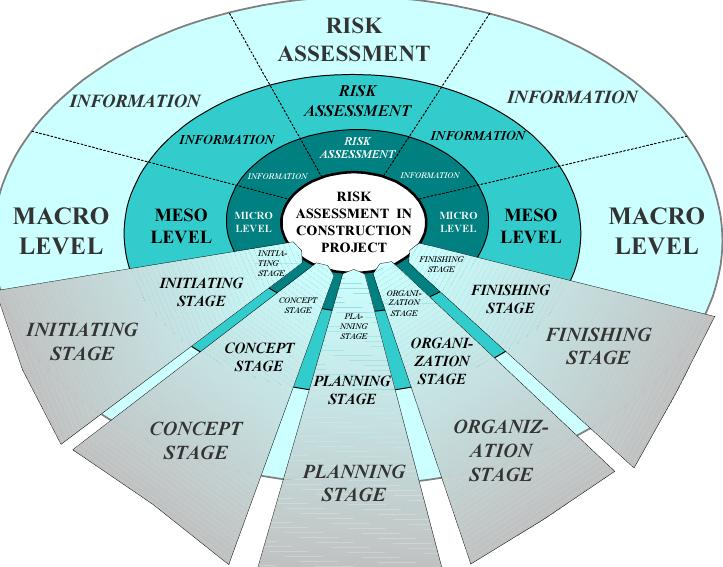
Fig. 1. R isk assessment di vided according to object life cycle environment